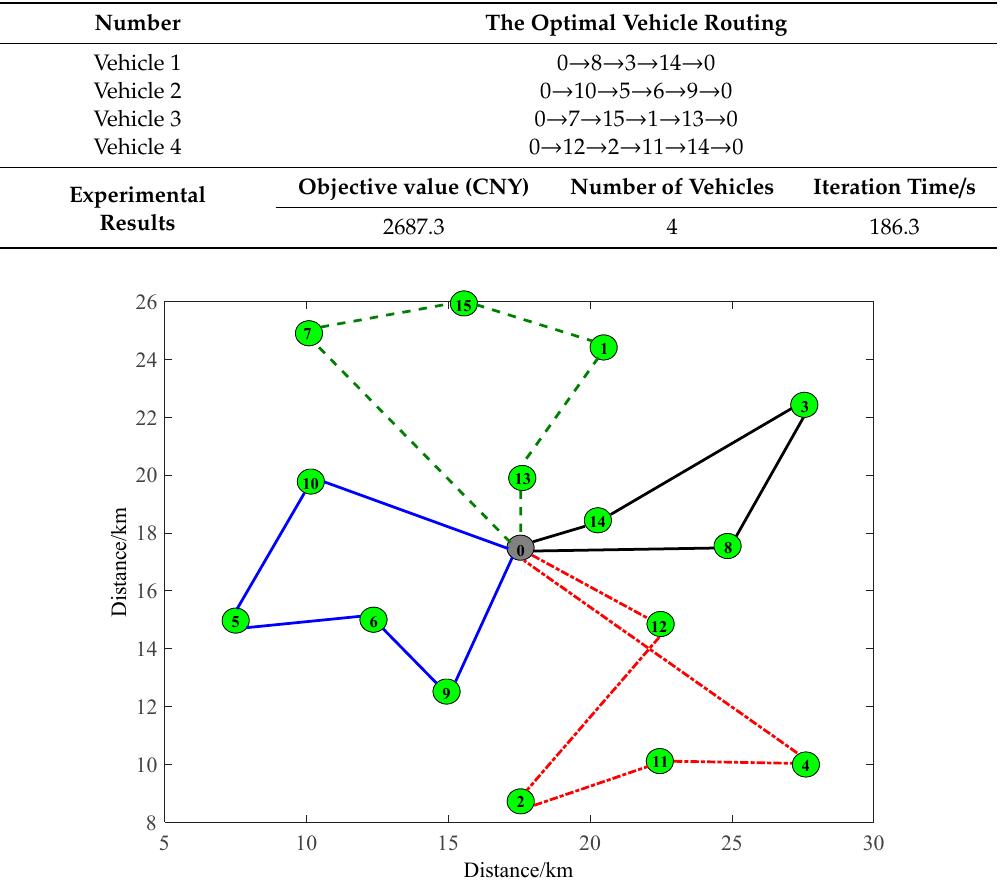
Figure 4. The optimal vehicle routing.